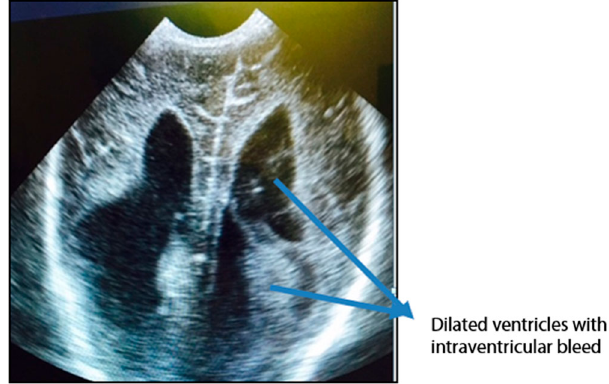
Figure 1: Cranial ultrasound scan: coronal view showing dilated ventri- cles with intraventricular haemorrhage.